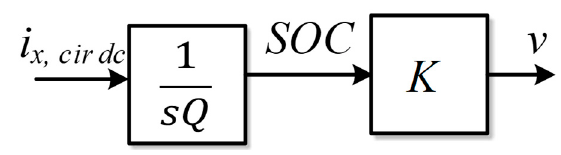
Figure 6. Plant transfer